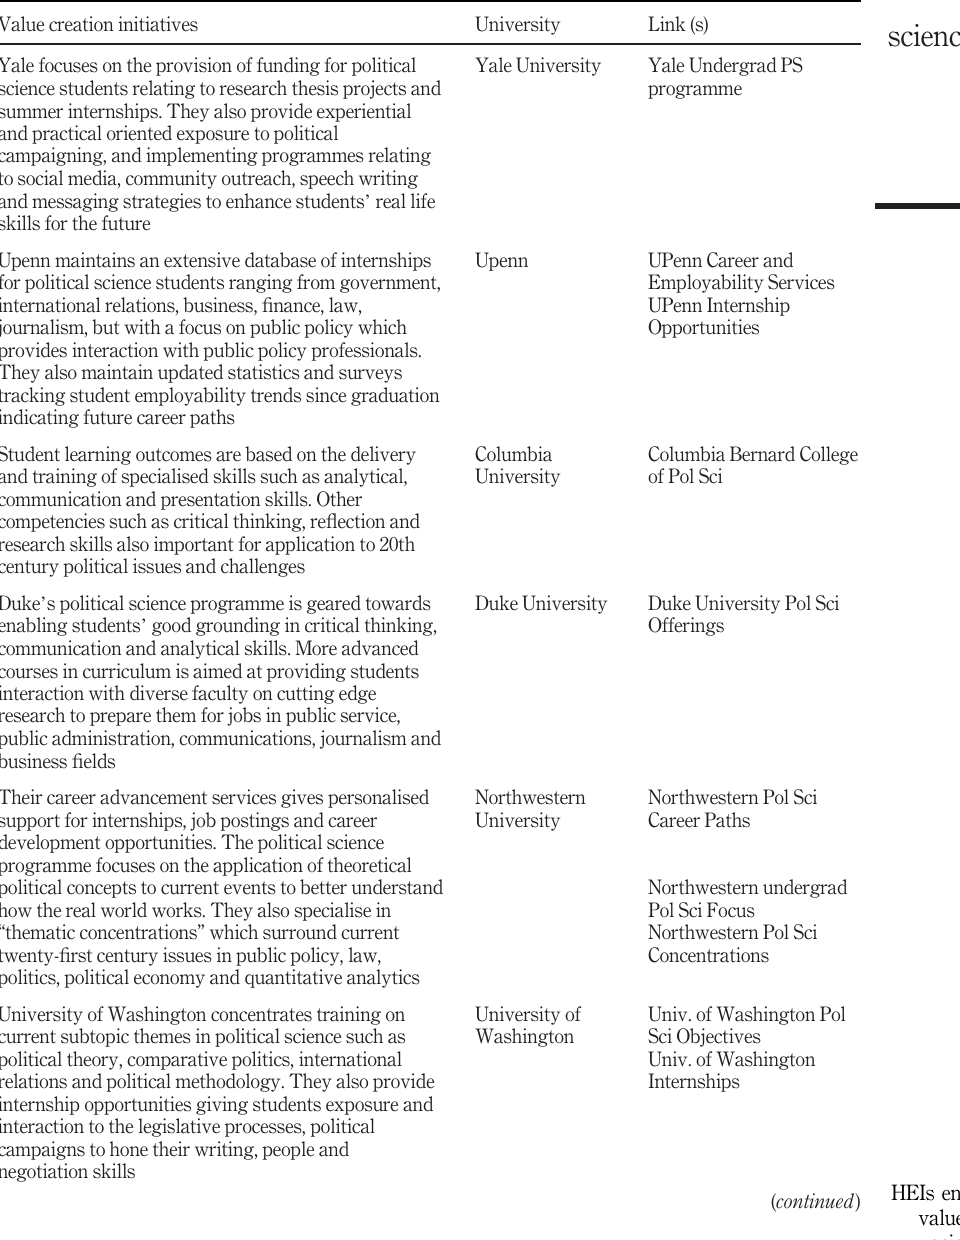
Table I. HEIs enhancing